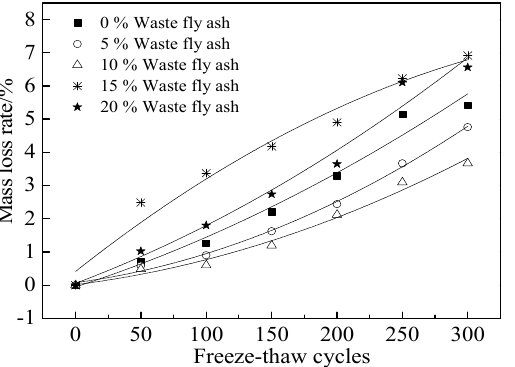
Figure 5. The measured mass loss rates of RPC with WFA during different NaCl freeze–thaw cycles. Table 4. Relations between the mass loss rate and NaCl freeze–thaw cycles ( N ). Equation WFA Content/% a b